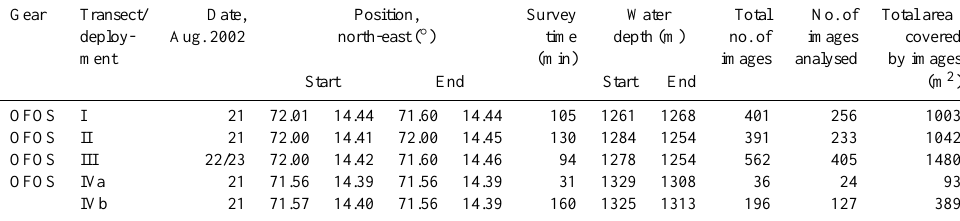
Table 1. Details of OFOS transects. Transects I, II and III – inside the caldera, transect IVa and b – reference site. Gear Transect/ Date, Position, Survey Water Total No. of Total area deploy- Aug. 2002 north-east ( ◦ ) time depth (m) no. of images covered ment (min) images analysed by images Start End Start End (m 2 ) OFOS